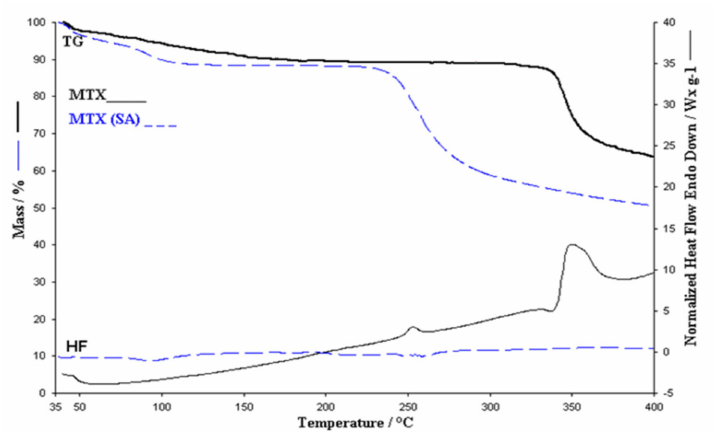
Figure 2. TG (Thermogravimetric) and Heat Flow (HF) curves of MTX and